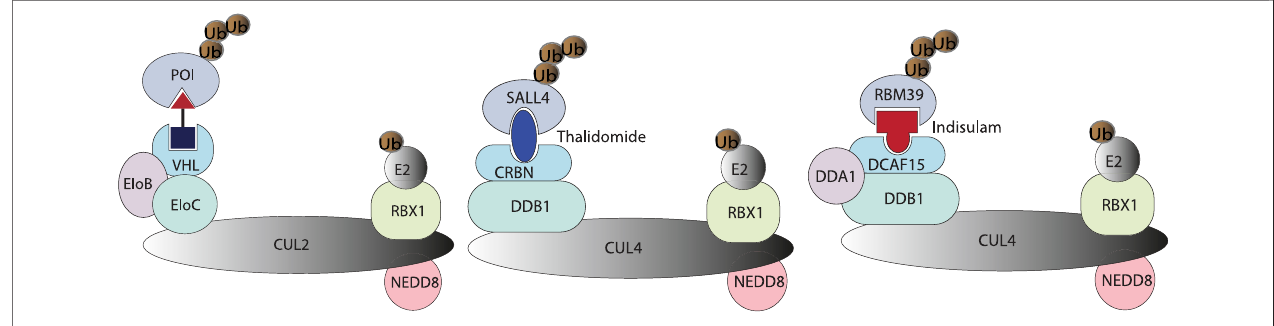
FIGURE 5 | A PROTAC molecule is represented by a heterobifunctional molecule with a linker, which induces proximity between VHL and POI. Molecular glue degraders are represented by Thanlidomide and Indisulam-induced protein-protein interaction between neosubstrate and substrate-binding subunit of E3 ubiquitin ligase (Bulatov and Ciulli